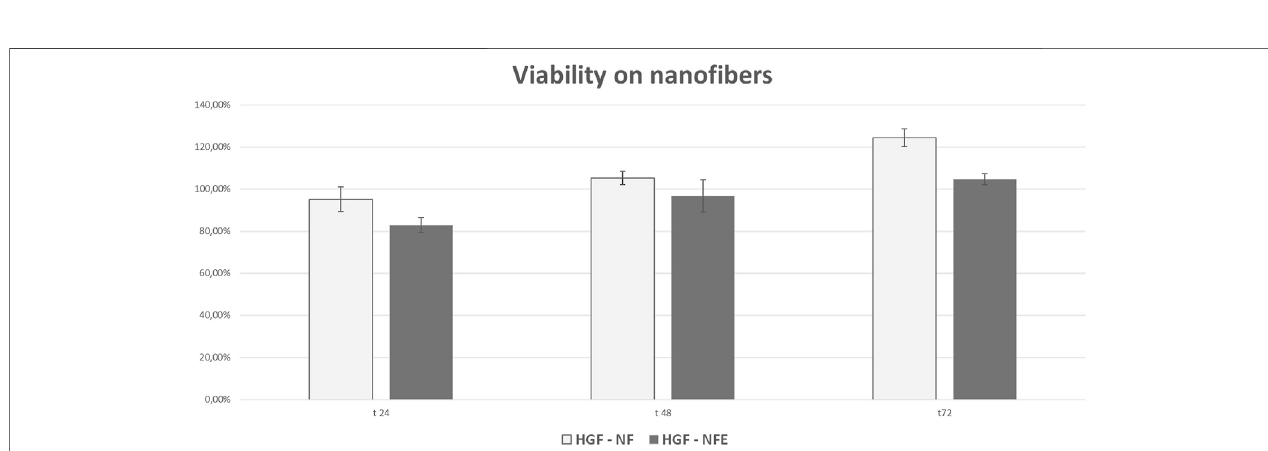
FIGURE 4 | Bar graphs showing cell viability and proliferation of HGF expressed as a % relative to CT (considered as the 100%). At all the considered time points and experimental conditions, cell viability was higher than 80%, suggesting that nano fi bers do not elicit any evident